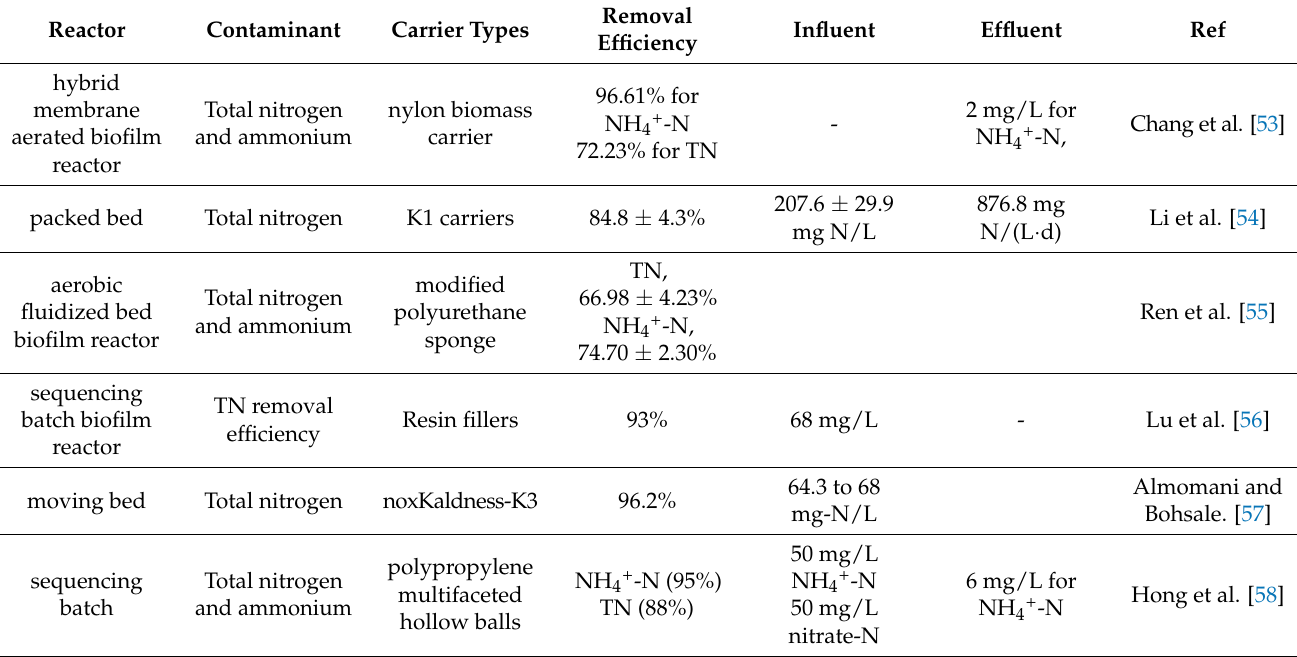
Table 1. Comparison of the performances of different biofilm reactors for the treatment of nitrogen and